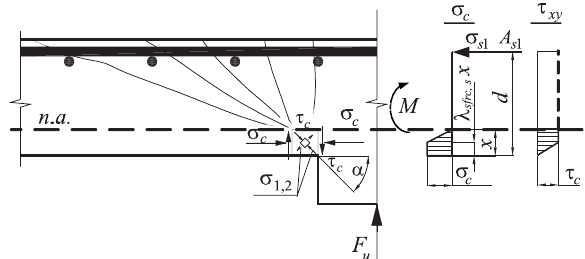
Fig. 2. Diagram of analytical model for